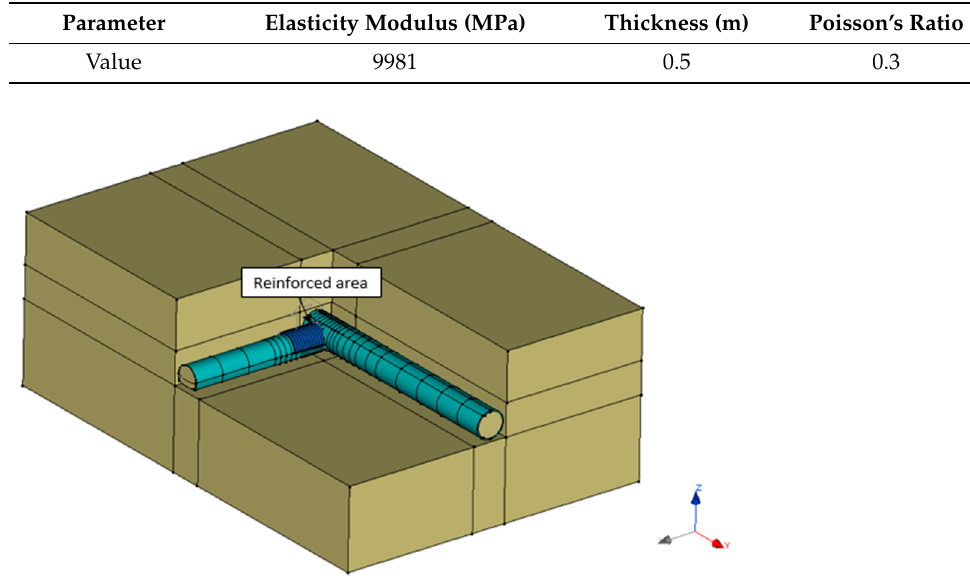
Figure 3. Three ‐ dimensional numerical model: ( a ) isometric view; ( b ) relative positions of the main tunnel and the cross passage. Table 1. Parameters chosen for the modelling of the umbrella vault.